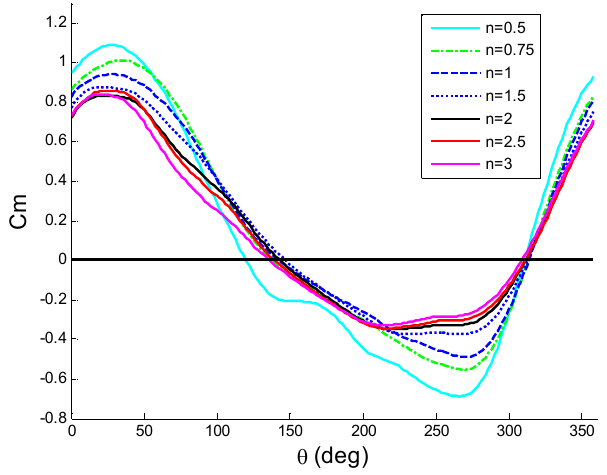
Figure 10. Blade dynamic torque coefficient for different blade fullness at λ = 0.8.